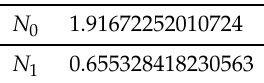
Table 6. N 0 and N 1 values derived through a MSE interpolation.